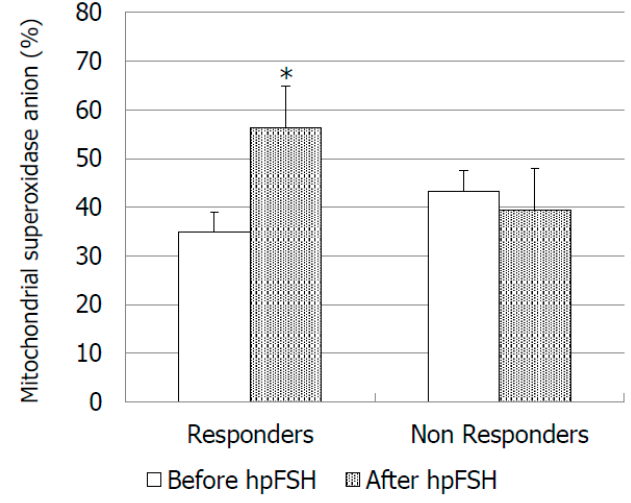
Figure 4. Percentage of spermatozoa with mitochondrial superoxide anion expression before and after treatment with high purified FSH (hpFSH) in infertile responder and non-responder patients. * p < 0.05